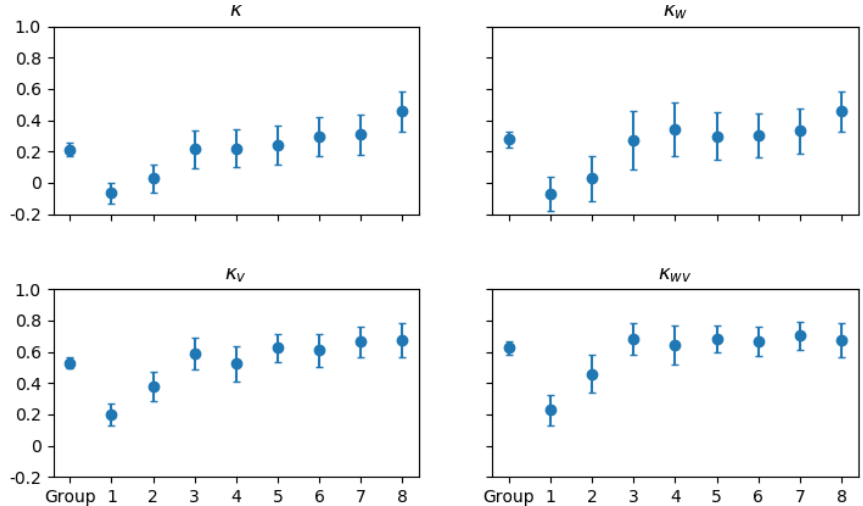
Figure 13. The kappa statistics of all eight analysts individually and as a group when compared to MAGIC segmentation. The vertical axis shows the kappa value. The horizontal axis shows whether it was the group or the individual analyst. κ includes all responses. κ v includes only responses where analysts determined segmentation results were acceptable. κ w is the weighted kappa value for all responses. κ wv is the weighted kappa for only segmentation results that were acceptable to analysts. The error bars show the upper and lower bounds for the 95% confidence